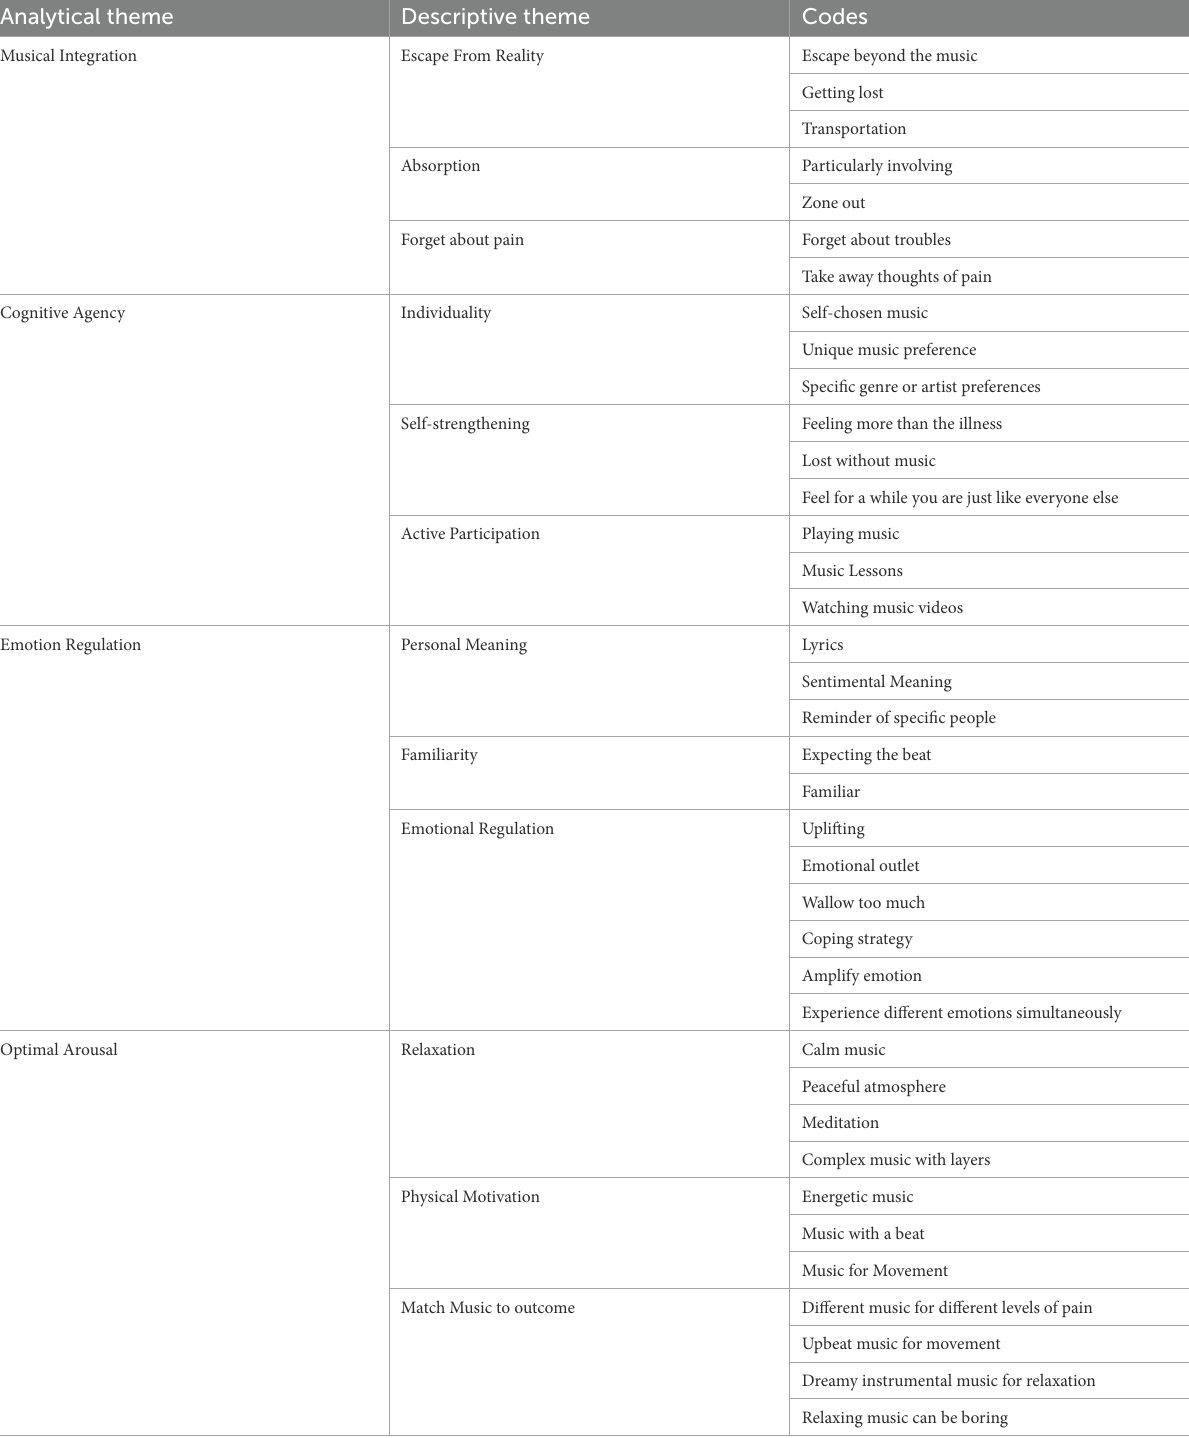
TABLE 4 Results of qualitative